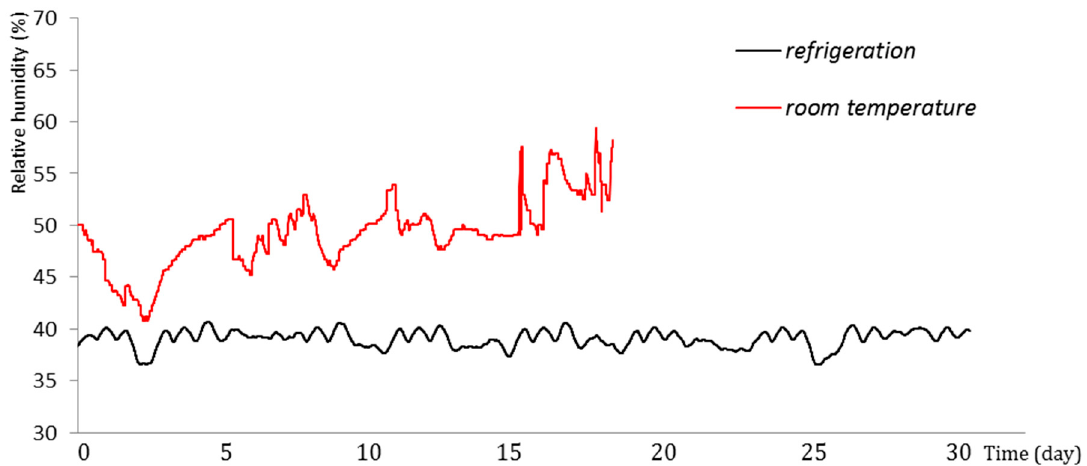
Figure 5. Time-humidity fluctuation of different storage conditions.